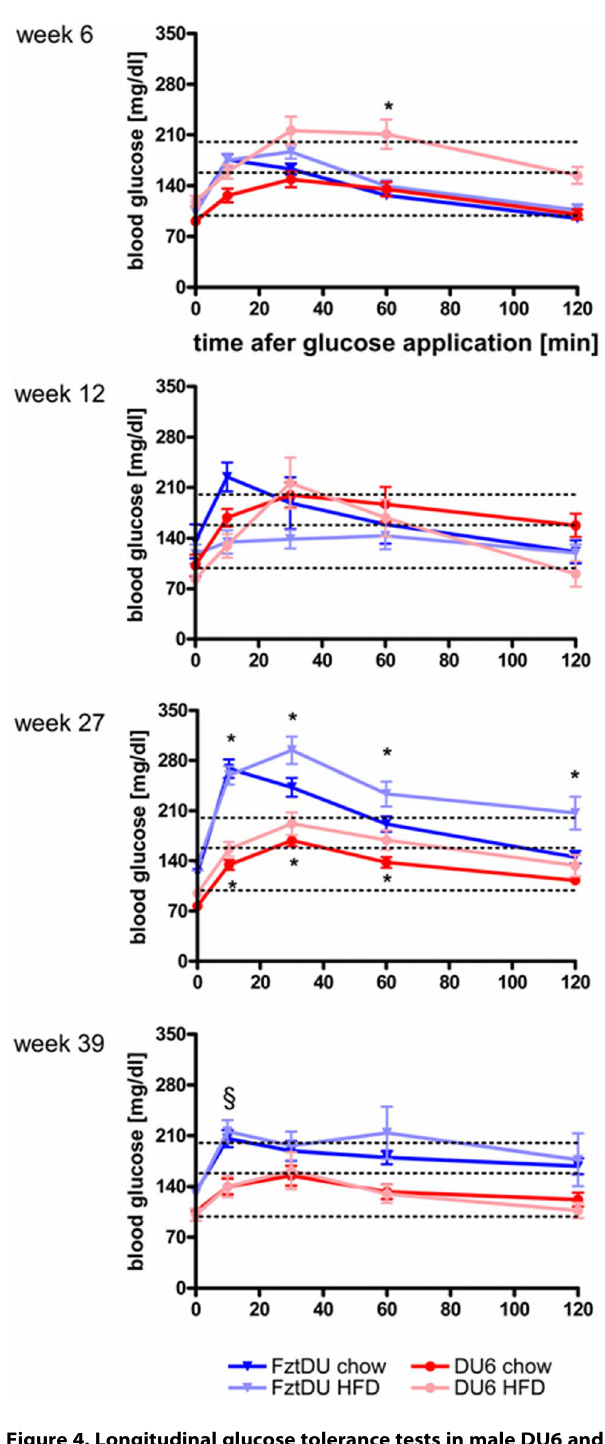
Figure 4. Longitudinal glucose tolerance tests in male DU6 and Fzt:DU mice under standard chow or HFD (n . 14; *: significant interaction of line, diet, age and repeated measures of glucose analysis with P , 0.05; 1 : significant interaction of line and age with P , 0.001).